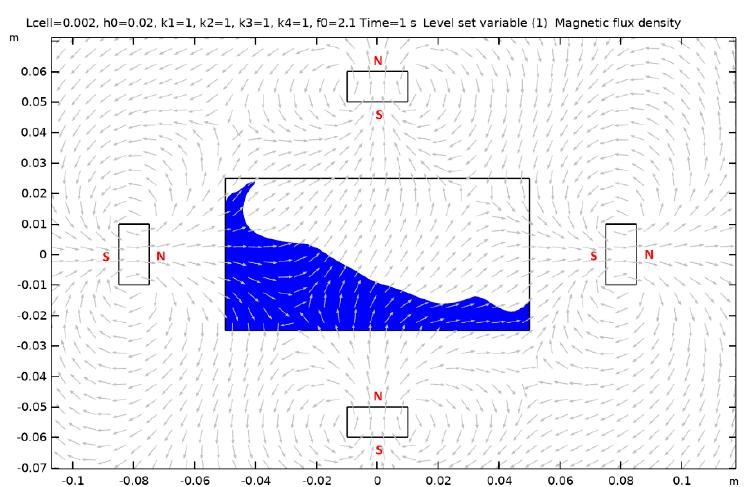
Figure A15. Case 16. Figure A15. Case